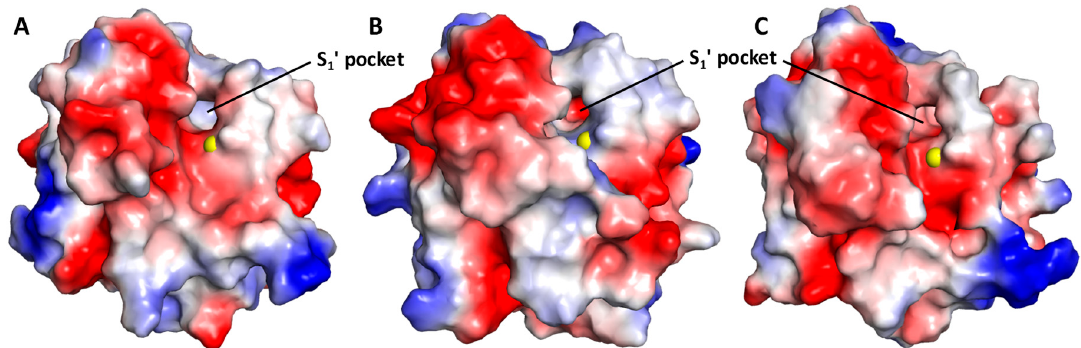
Figure 2. Electrostatic surface potential (ESP) map of MMP-8 ( A ), MMP-9 ( B ), and MMP-2 ( C ) showing electropositive regions (colored blue) that may serve as the site of binding for GAGs and NSGMs. Catalytic Zn 2+ is shown as a yellow sphere. Note the differences in the nature of ESPs between closely related MMPs, particularly inside the S 1 ’ pocket (blue vs. red), despite their relatively good sequence similarity/homology.